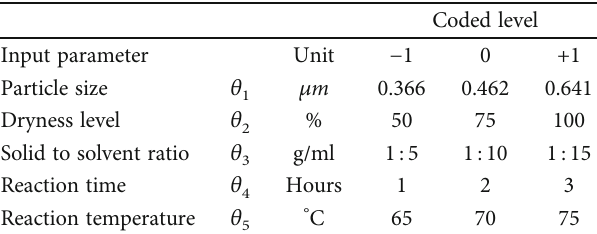
Table 1: Levels of the input